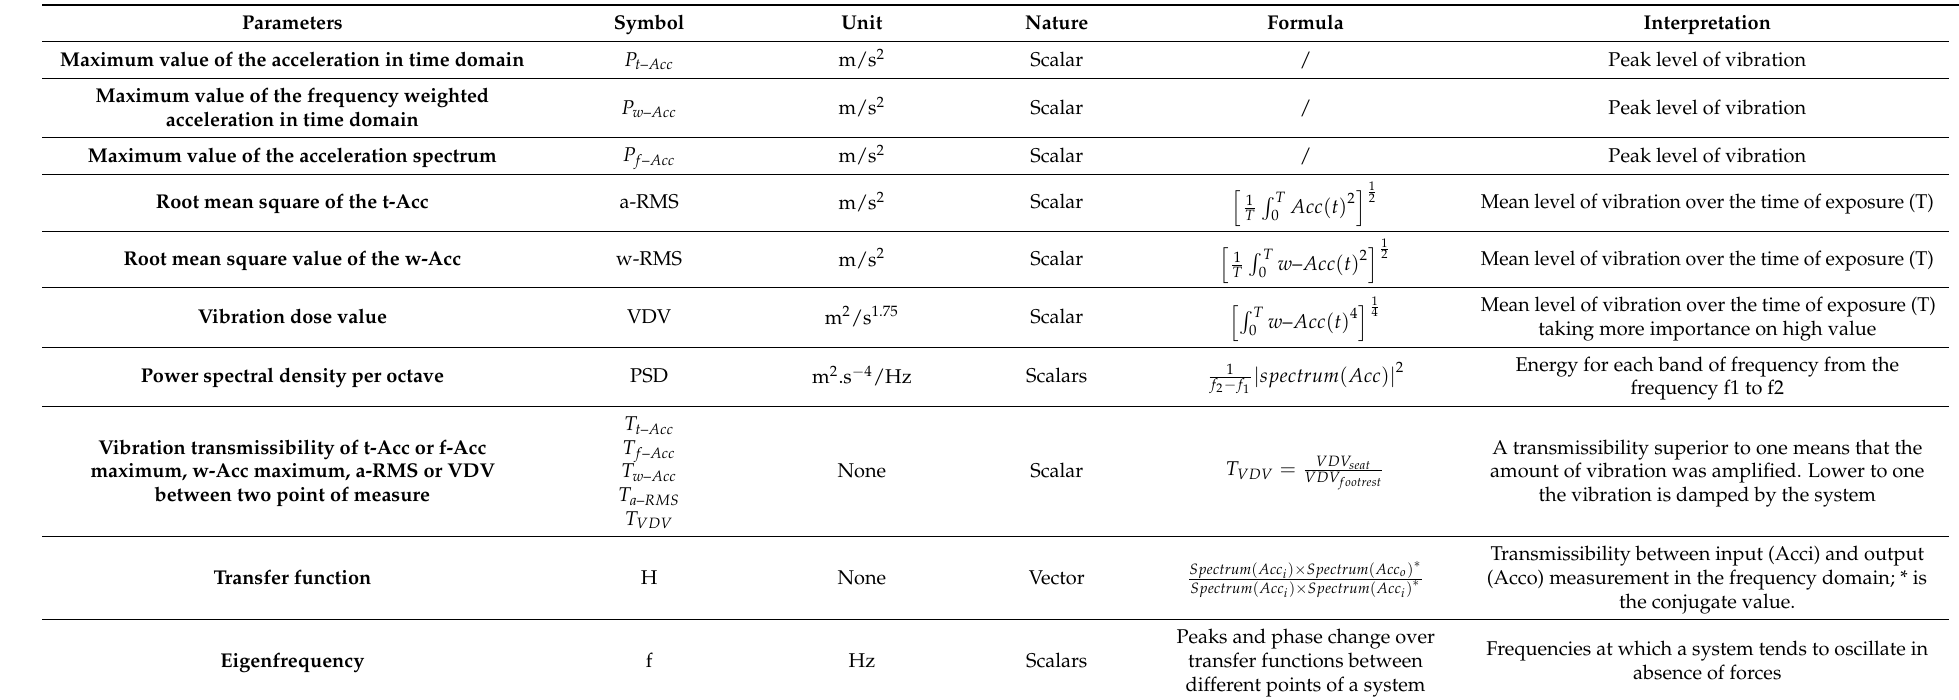
Table 1. Parameters of interest reported for vibration exposure during MWC